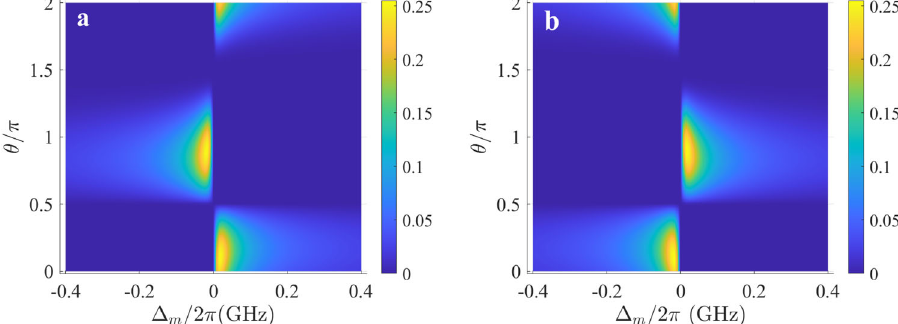
Fig. 6 Periodic asymmetric one-way steering. Quantum steering a G a ! b and b G b ! a as a function of the relative phase θ and frequency detuning Δ m . The corresponding parameters are J /2 π = Γ /2 π = 5 MHz, and the other parameters are the same as those in Fig. 2.